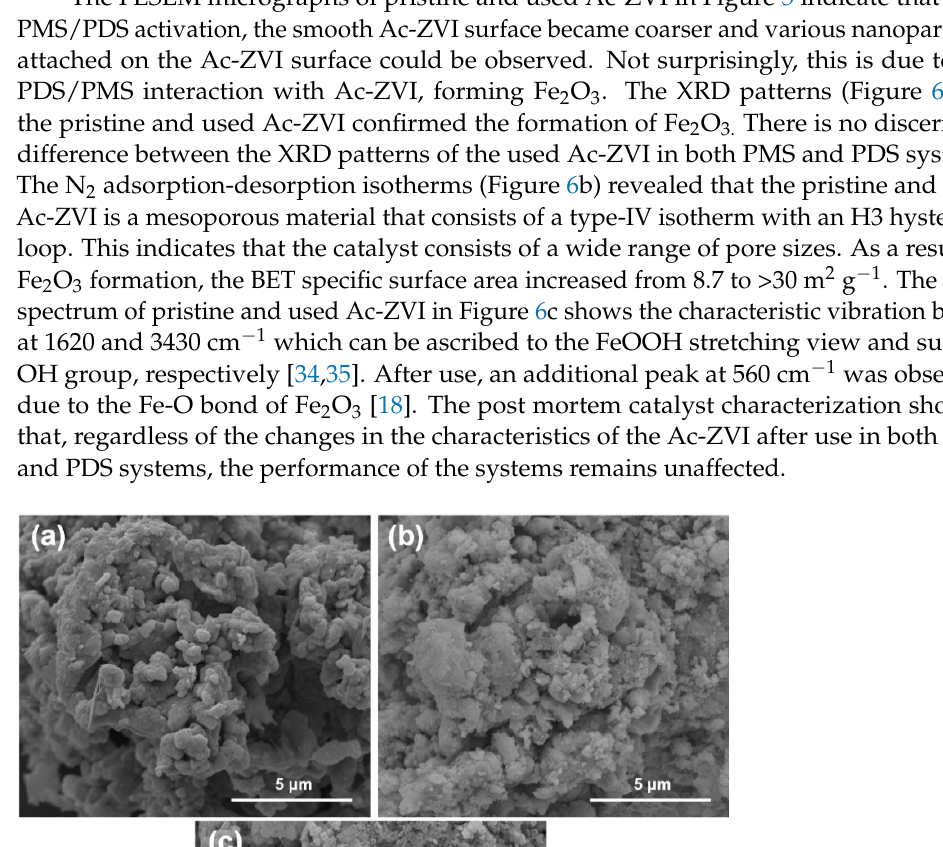
Figure 6. ( a ) XRD patterns; ( b ) nitrogen adsorption-desorption isotherms; and ( c ) FTIR spectra of pristine and used Ac-ZVI.